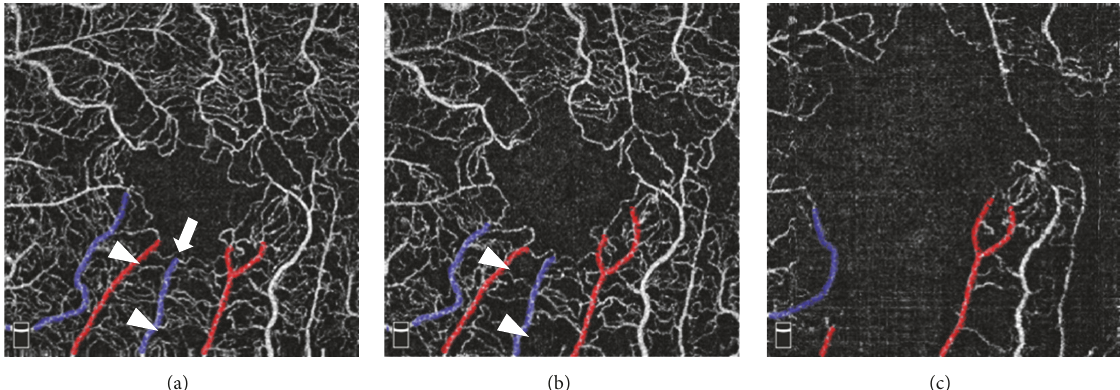
Figure 6: OCTA images in the left eye (a) 1 month, (b) 2 months, and (c) 4 months after the initial visit. The artery is colored red and the vein is colored blue. Detailed sequential OCTA observations reveal progressive capillary dropout from the areas around the vein (arrow), followed by disappearance of the vein surrounded by avascular areas